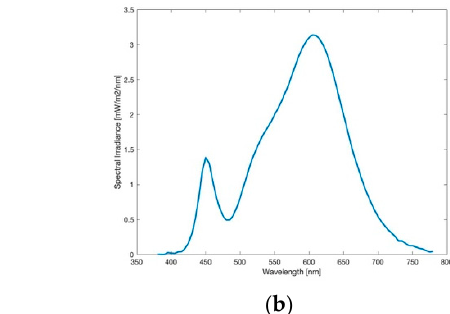
Figure 6. ( a ) Image of ball light during night-time taken with fisheye lens for detailed analysis (date: 29.07.2019, 23:15 h; exposure time: 0.4 s); ( b ) Luminance matrix of image (a) as displayed by SQC; ( c ) CCT matrix of image (a) as displayed by SQC.